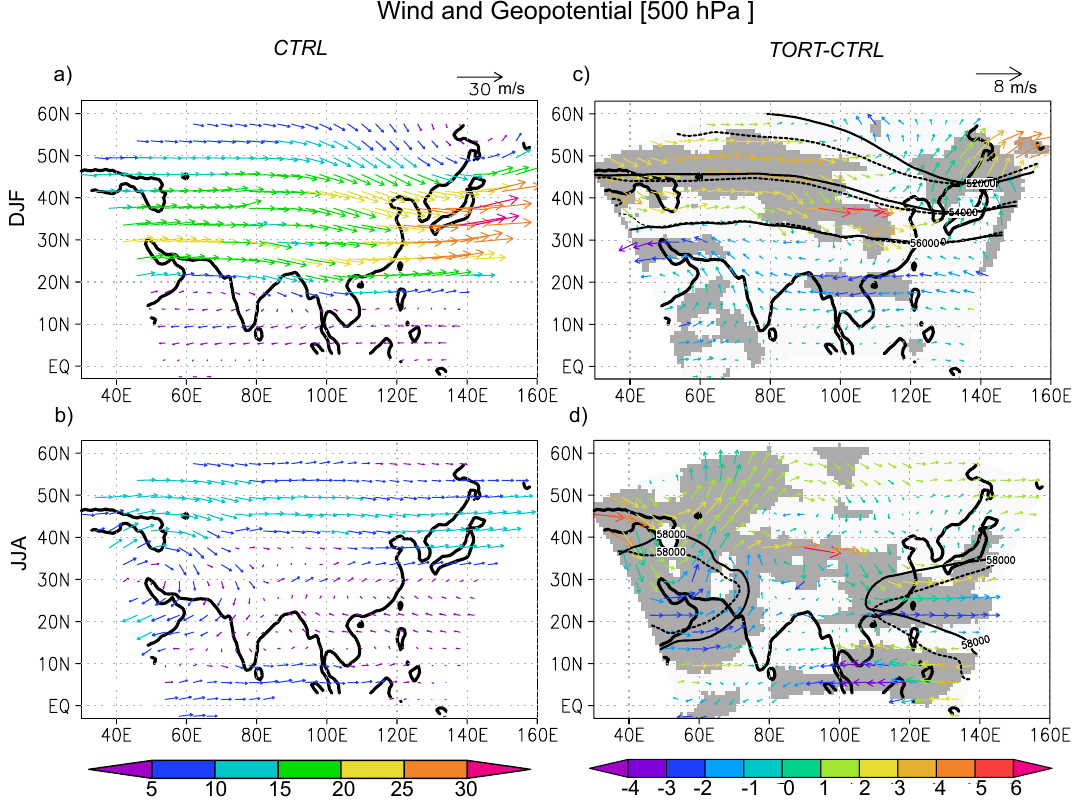
Fig. 6. Winter (DJF) and summer (JJA) wind (ms − 1 ) at 500hPa. (a, b) CTRL, (c, d) difference between TORT and CTRL. The grey shaded areas in (c, d) indicate the regions where either the zonal or the meridional wind anomalies are significant with a Student’s t-test ( p = 0 . 05). The contour lines represent the geopotential (m 2 s − 2 ) in CTRL (solid) and TORT (dashed). The colour of vectors denotes the absolute wind speed in (a, b) and the difference of wind speed in (c, d)